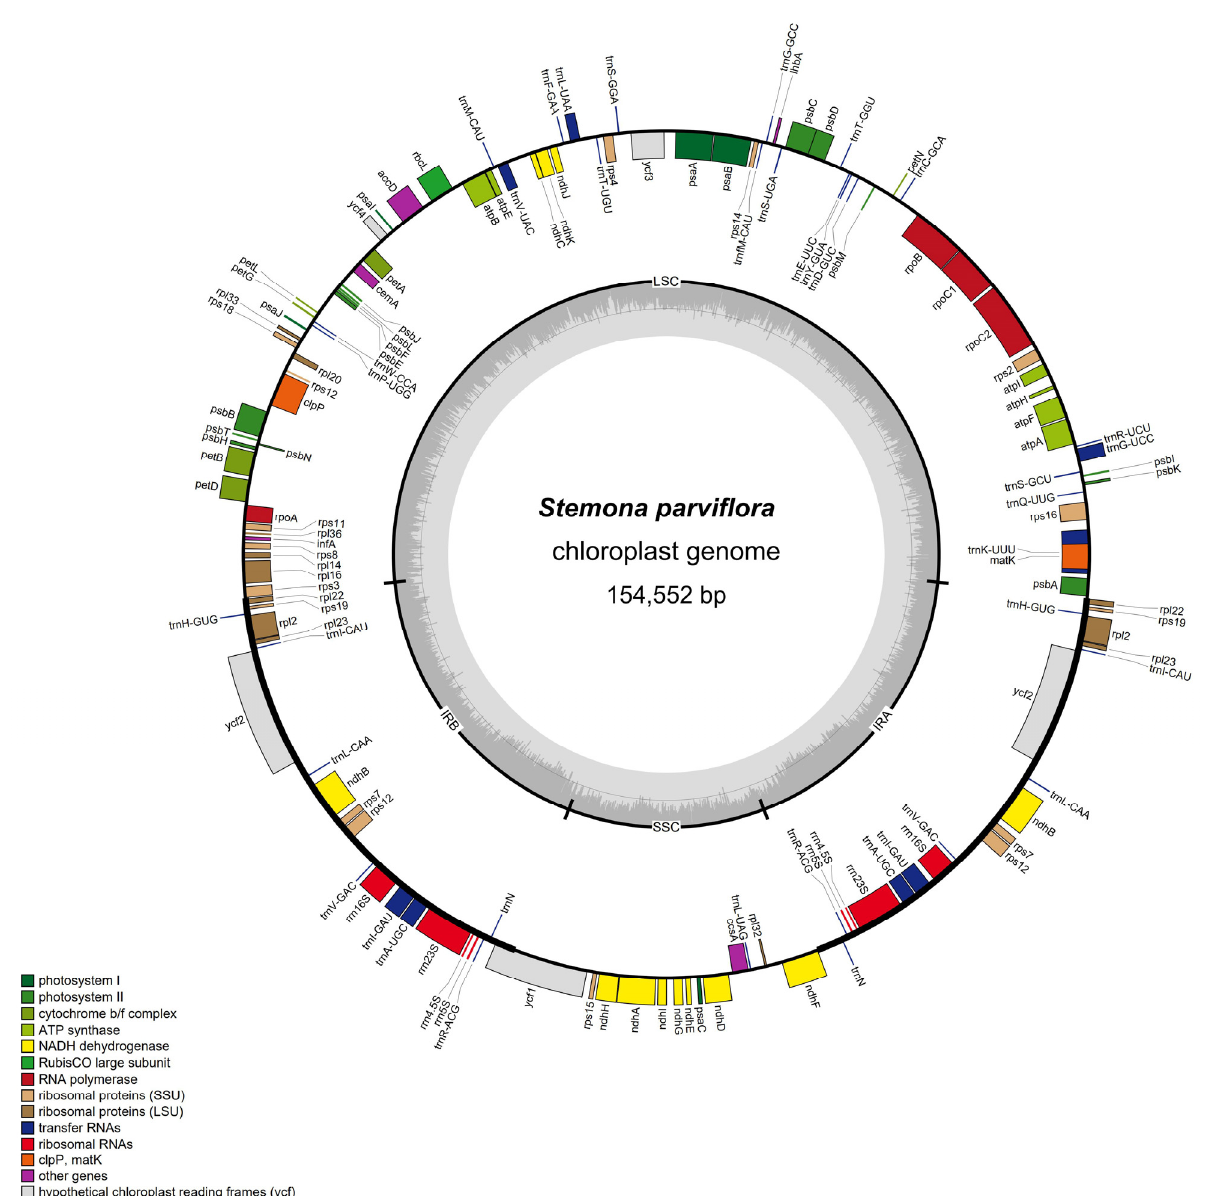
Figure 1. Chloroplast genome map of Stemona parviflora.